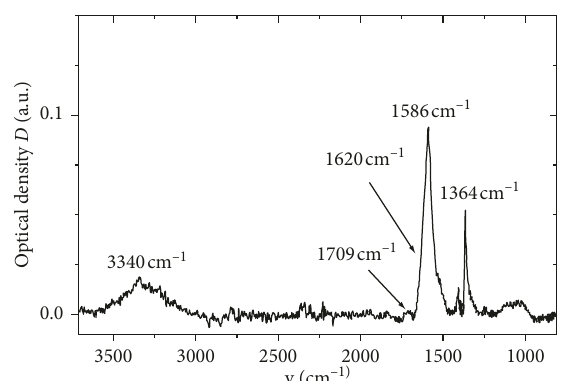
Figure 3: FTIR absorption spectrum of the graphene oxide film deposited on a ZnSe substrate.